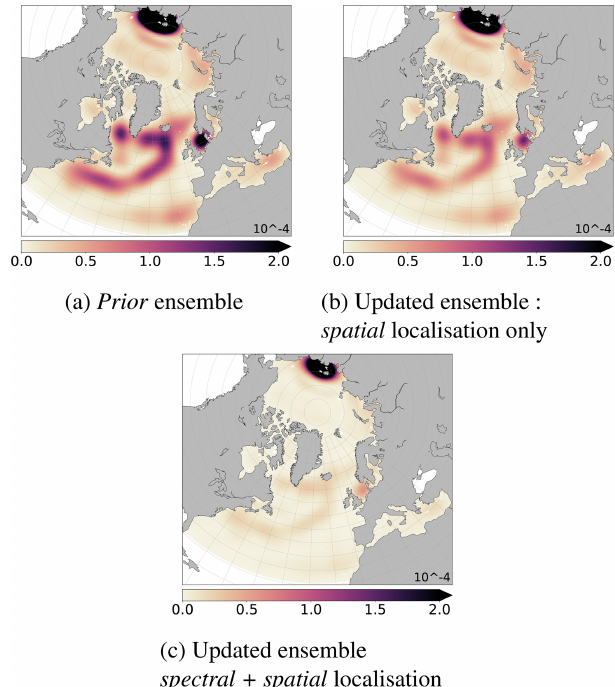
Figure 11. Ensemble spread of the prior (a) , the updated ensembles obtained with (a) the spatial localisation only or with (c) the multi- scale analysis (spectral + spatial localisation), according to Eq. (15) (full spectrum) for the SSH.